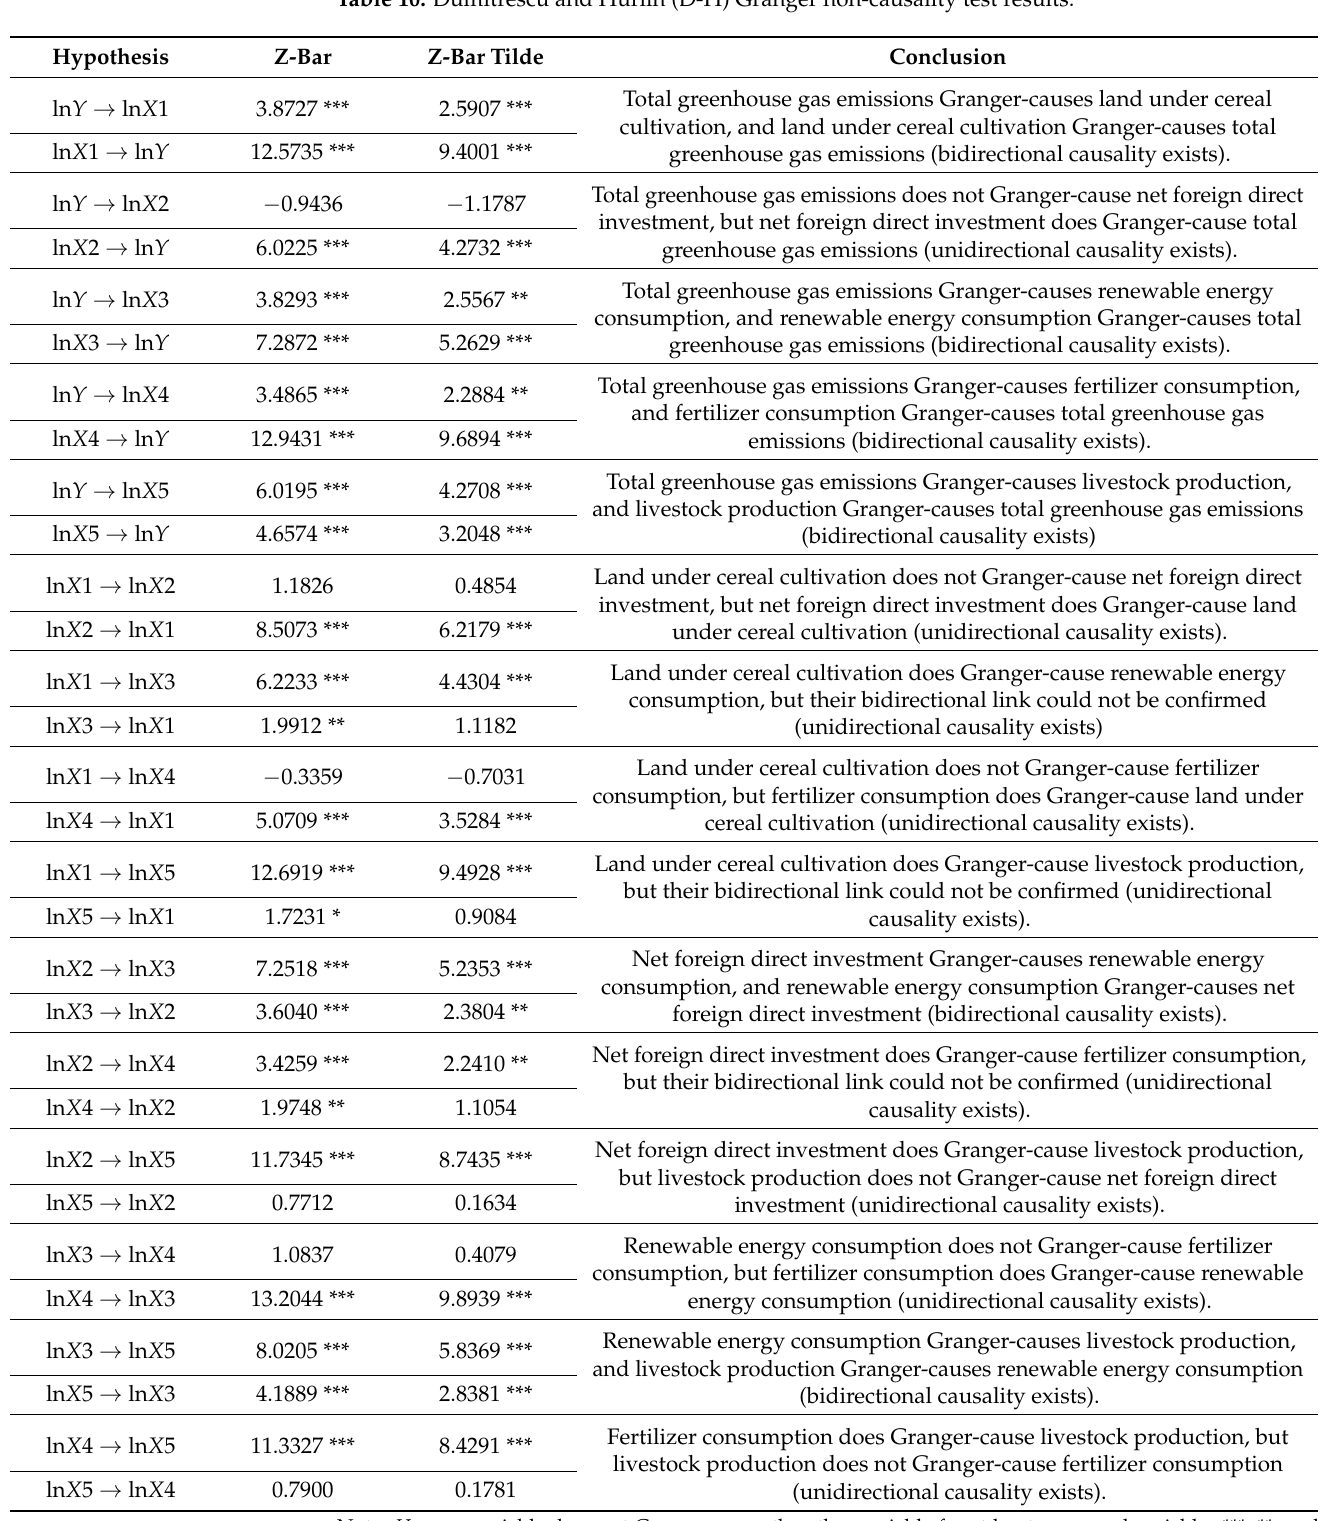
Table 10. Dumitrescu and Hurlin (D-H) Granger non-causality test results.